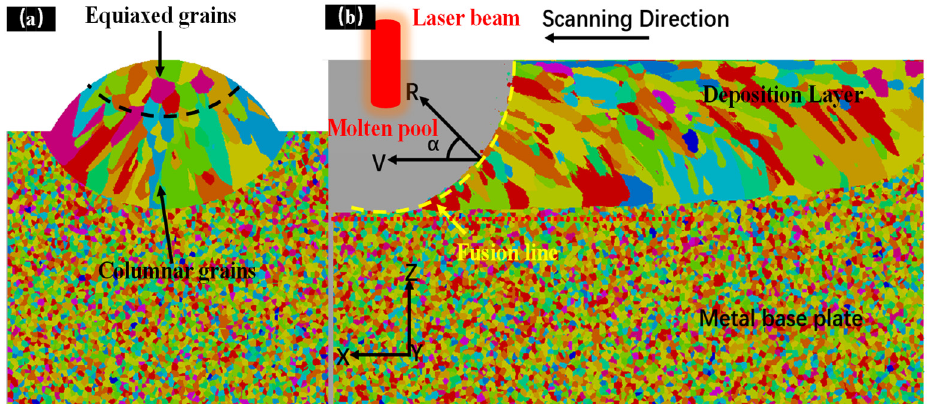
Figure 9. Schematic illustration of grain growth: ( a ) longitudinal cross-section; ( b ) transverse cross- section.